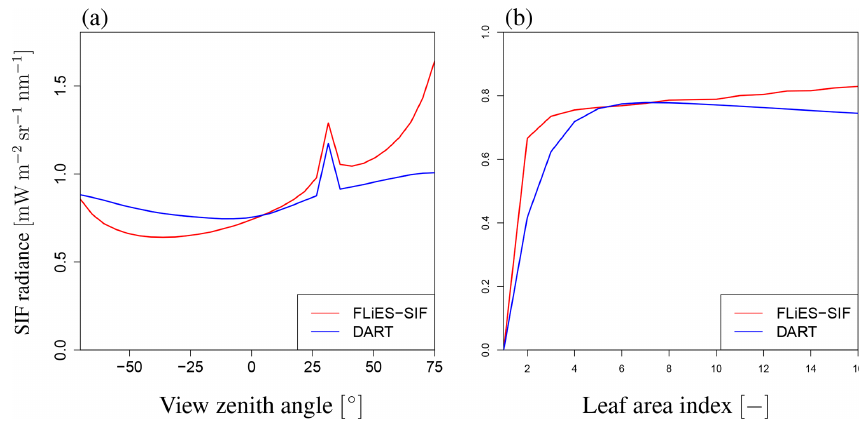
Figure 10. Comparison of SIF radiance with DART model. These figures indicate (a) VZA dependency (LAI of 3.0) and (b) LAI dependency (VZA of 0 ◦ ), respectively. SZA and SAA values are 20 and 0 ◦ , respectively. The red and blue lines indicate the results of FLiES-SIF and DART, respectively. FLiES-SIF has similar dependency on LAI and VZA to DART, although FLiES-SIF has higher angular dependency.